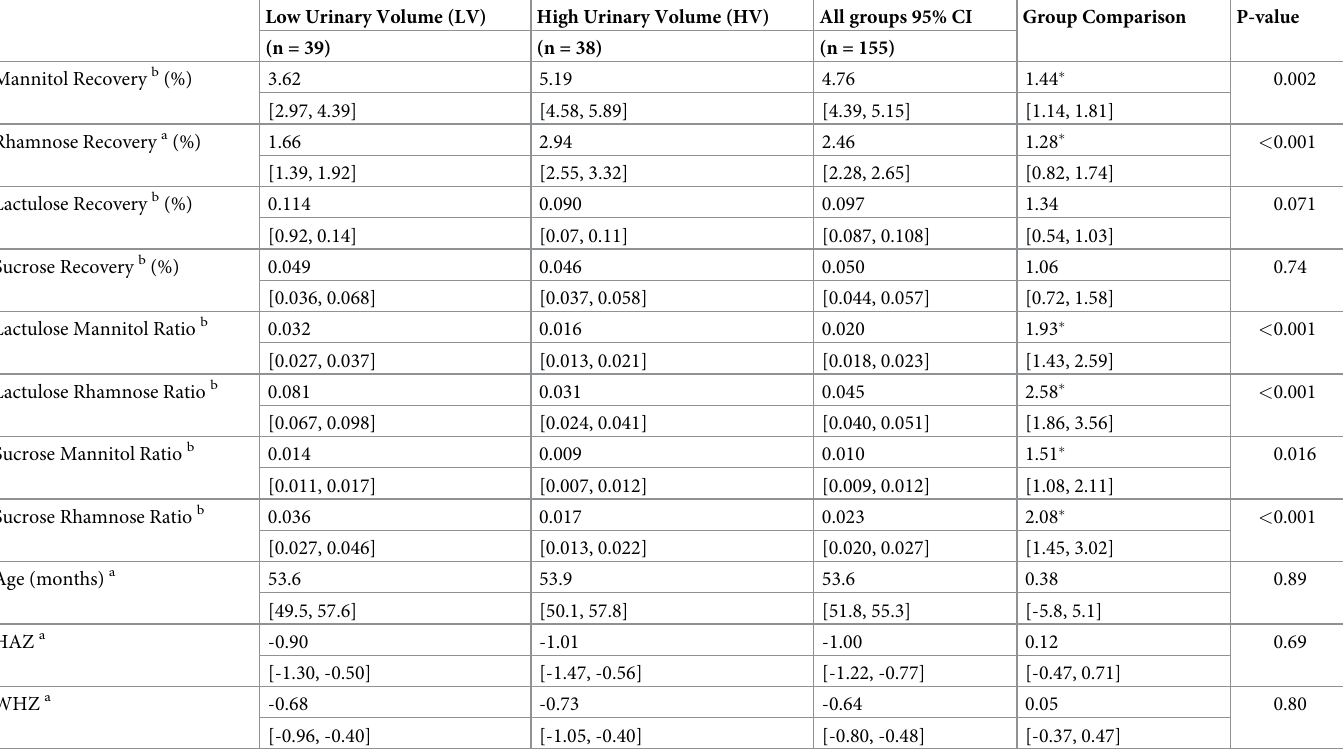
Table 1. Sugar recovery and recovery ratios in low and high urinary groups.